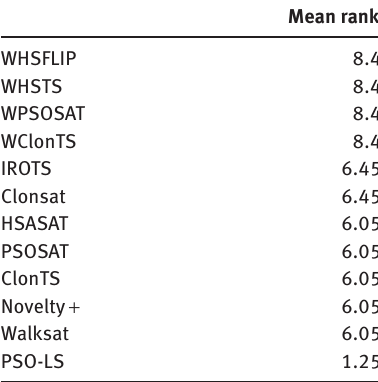
Table 6: Friedman Test.